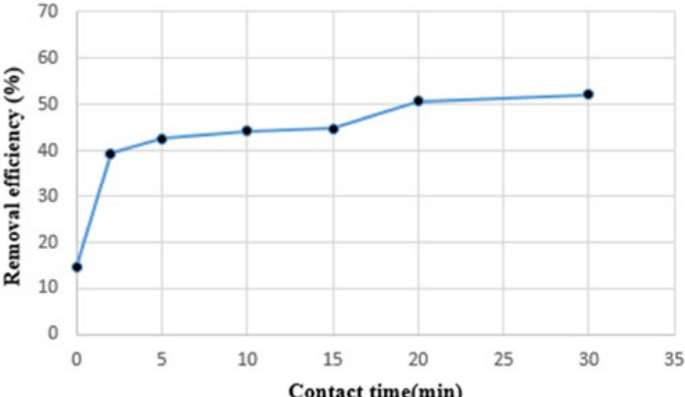
Fig. 7. Efficacy of contact time on cadmium removal process by palladium oxide Fig7. Efficacy of contact time on cadmium removal process by palladium oxide nanoparticles